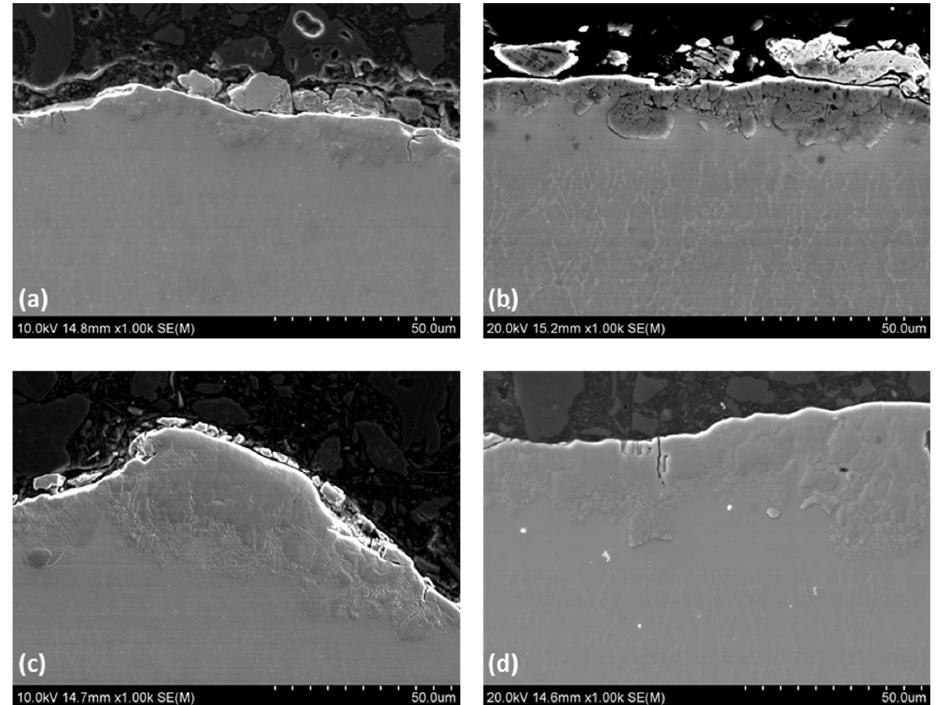
Figure 11. Cross section SEM images for ( a ) 9 A—25 µ s, ( b ) 13 A—50 µ s, ( c ) 17 A—100 µ s, and ( d ) 25 A—200 µ s machining